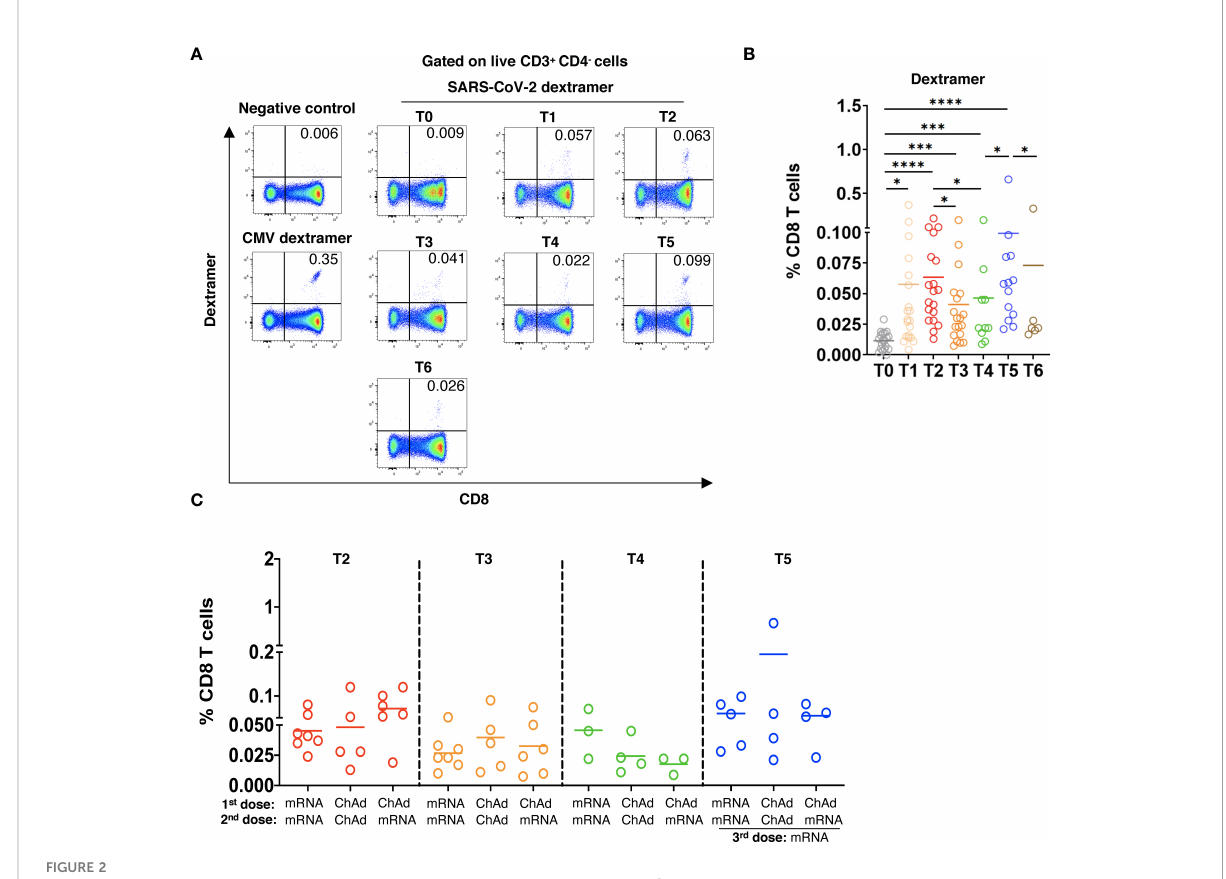
FIGURE 2 Induction of SARS-CoV-2 speci fi c CD8 T cells after vaccination. PBMC (2x10 6 ) were stained with MHC I dextramers containing SARS-CoV-2 spike peptides and the HLA-A allele that was chosen according to the HLA-A typing of each participant (Supplementary Tables 2, 3) followed by fl ow cytometry. (A) Representative dot plots for SARS-CoV-2-speci fi c CD8 T cells (dextramer + CD8 + ), for cells stained with negative control dextramers (T5), or for CMV speci fi c CD8 T cells (positive control, T5). (B) Spike speci fi c CD8 T cells in vaccinated participants are shown as the percentage of dextramer + CD8 + T cells within total CD8 T cells with the subtraction of positively stained cells in the negative control (n=21). (C) Virus speci fi c CD8 T cells in participants vaccinated two times with mRNA (mRNA/mRNA, n=7), two times with ChAd (ChAd/ChAd, n=5) or with ChAd/mRNA (n=5) are shown as the percentage of dextramer + CD8 + T cells among total CD8 T cells. *P<0.05, ***P<0.001,